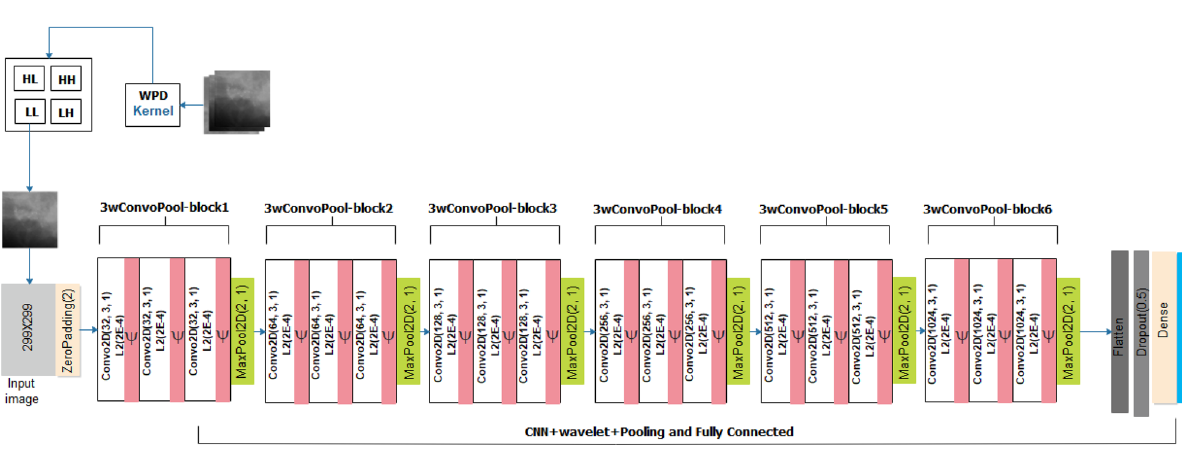
Figure 5. The proposed wCNN model architecture for characterization abnormalities in breast images using features from the WPD operation and wavelet function in the convolutional